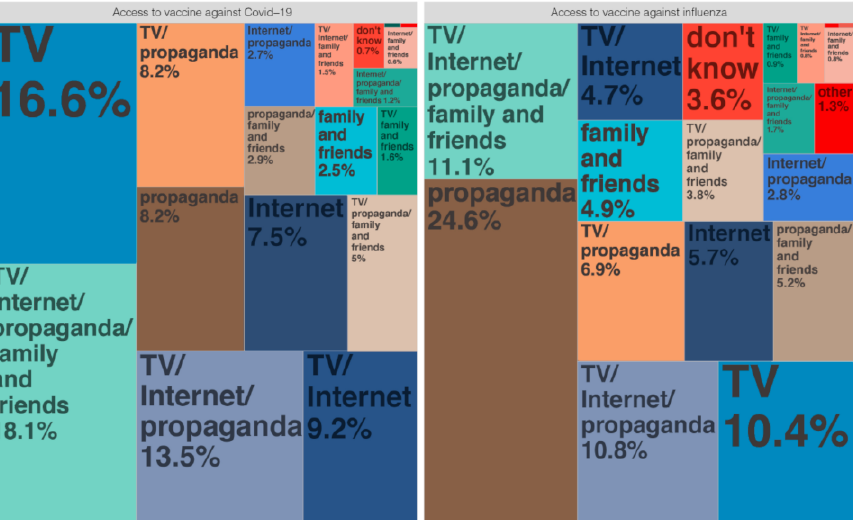
Figure 3. Sources of different vaccine information. TV means TV, radio, and newspapers; internet included QQ, WeChat, Weibo, news websites, etc.; propaganda means community or hospital propaganda.